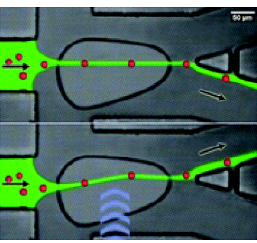
Figure 1. Surface acoustic wave actuated cell sorting (SAWACS) in a microfluidic PDMS channel (prepared in the lab of the first